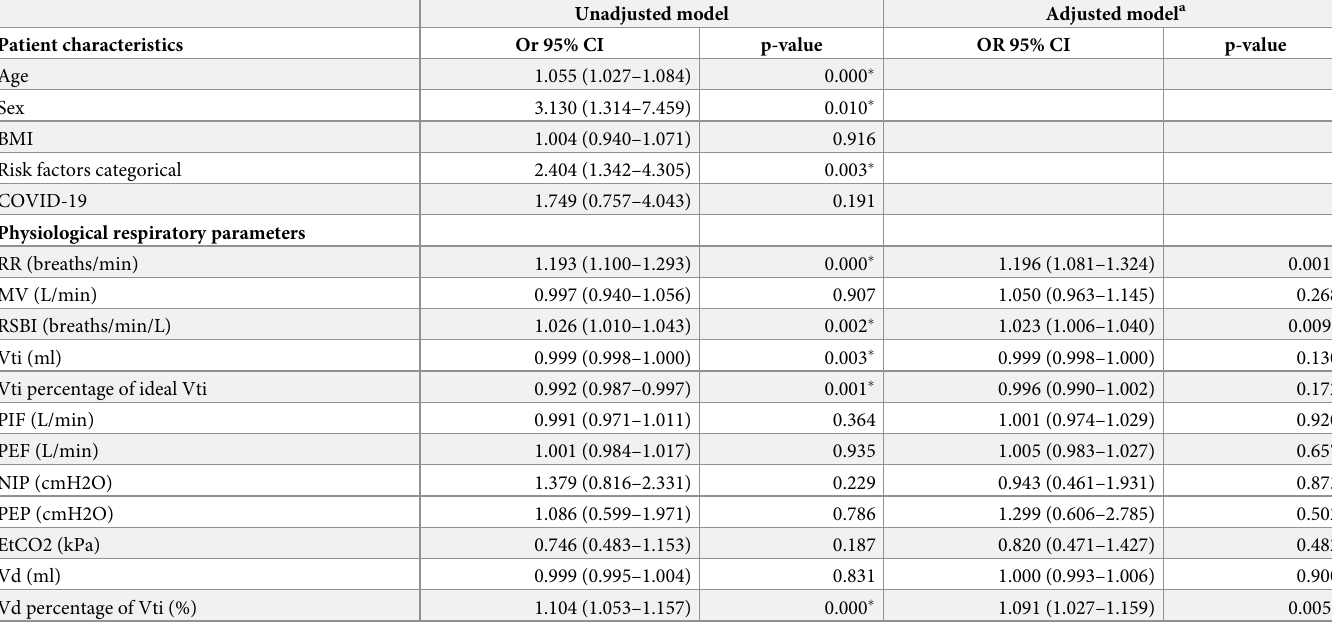
Table 6. Logistic regression models of physiological respiratory parameters effects on the odds of hospital